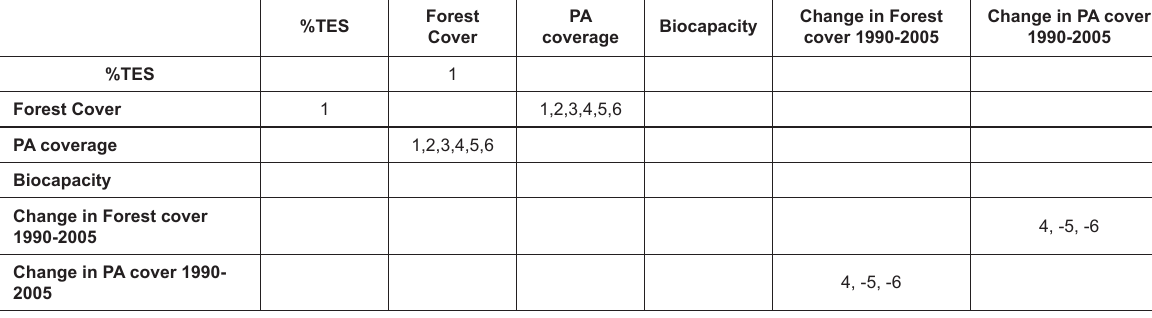
Table 1. Correlation within biodiversity indicators across continents. Only significant correlations (p < 0.05) are